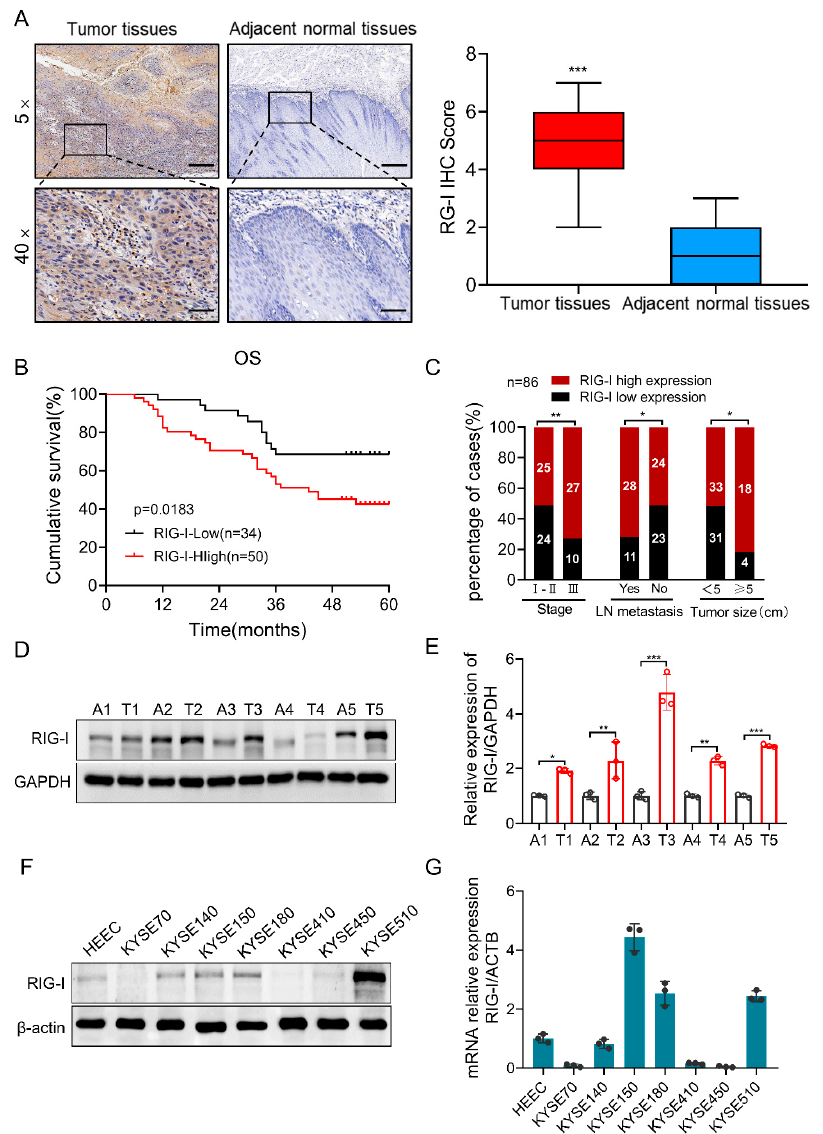
Figure 1. Protein and mRNA expression of RIG-I in ESCC tissues and adjacent normal tissues and cell lines. ( A ) The expression level of RIG-I protein in ESCC tissues and adjacent normal tissues was analyzed using immunohistochemistry (magnification 5 × or 40 × ), Representative pictures are displayed; scale bar = 50 µ m. Box plot showing immunohistochemical staining scores of RIG-I in ESCC samples (ESCC tissues = 86 and adjacent normal tissues = 86) ( B ) Kaplan–Meier analysis of the relationship between RIG-I protein expression and overall survival of patients with ESCC. ( C ) Correlation between RIG-I protein levels and clinicopathological parameters of patients with ESCC. ( D ) Protein and ( E ) mRNA expression levels of RIG-I in fresh ESCC cancer tissues and adjacent normal tissues were examined using Western blotting and qRT-PCR. GAPDH was used as an internal control. Expression of RIG-I ( F ) protein level and ( G ) mRNA level in HEEC and ESCC cells was detected using Western blotting and qRT-PCR. The mRNA values of three independent experiments were shown black dot. ACTB was used as an internal control. Data are shown as mean ± standard deviation (SD) from three independent experiments. * p < 0.05, ** p < 0.01, and *** p <